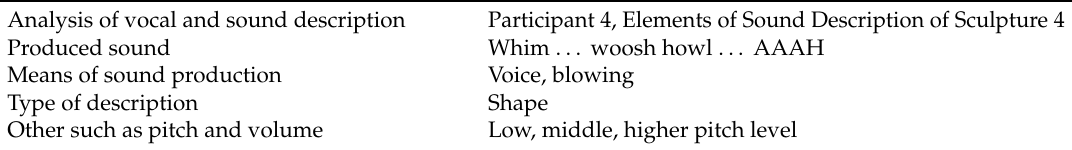
Table 3. Vocal and sound descriptions by participant